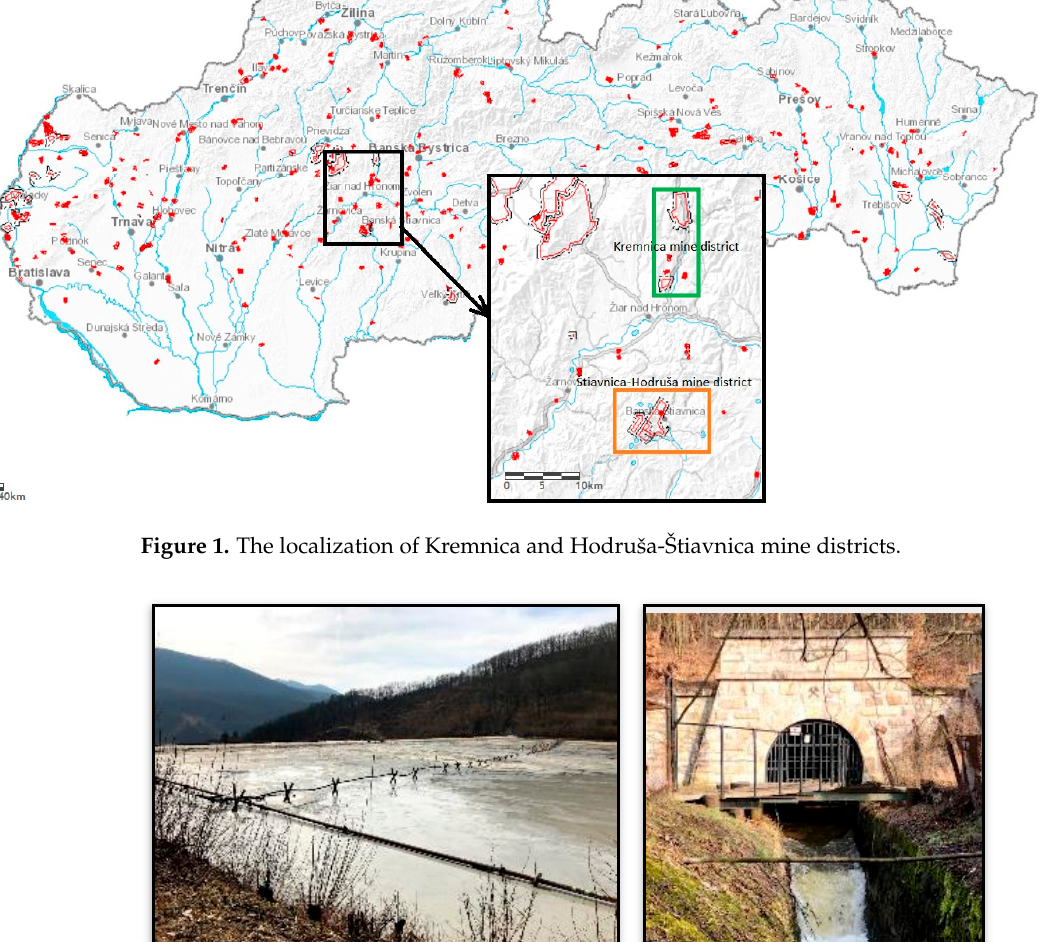
Figure 2. Tailings pond in Hodruša-Hámre (Hodruša-Štiavnica ore district) and the main inheritance adit (Kremnica ore district). Table 1. Geographic coordinates of sampling sites and on-site pH